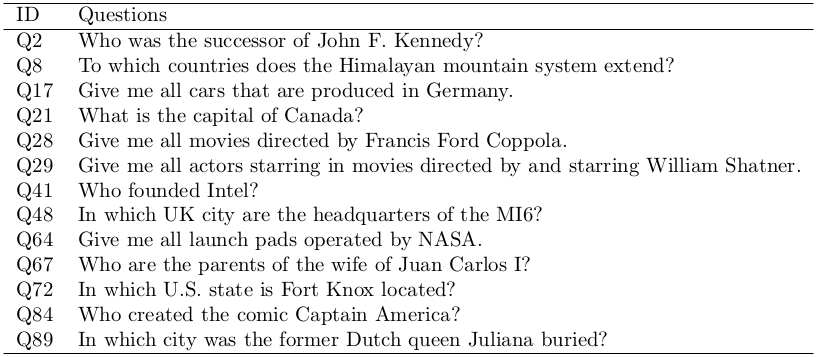
Table from the paper: A Graph Traversal Based Approach to Answer Non-Aggregation Questions Over DBpedia
Table text:
ID
Questions
Q2
WhowasthesuccessorofJohnF.Kennedy?
Q8
TowhichcountriesdoestheHimalayanmountainsystemextend?
Q17
GivemeallcarsthatareproducedinGermany.
Q21
WhatisthecapitalofCanada?
Q28
GivemeallmoviesdirectedbyFrancisFordCoppola.
Q29
GivemeallactorsstarringinmoviesdirectedbyandstarringWilliamShatner.
Q41
WhofoundedIntel?
Q48
InwhichUKcityaretheheadquartersoftheMI6?
Q64
GivemealllaunchpadsoperatedbyNASA.
Q67
WhoaretheparentsofthewifeofJuanCarlosI?
Q72
InwhichU.S.stateisFortKnoxlocated?
Q84
WhocreatedthecomicCaptainAmerica?
Q89
InwhichcitywastheformerDutchqueenJulianaburied?